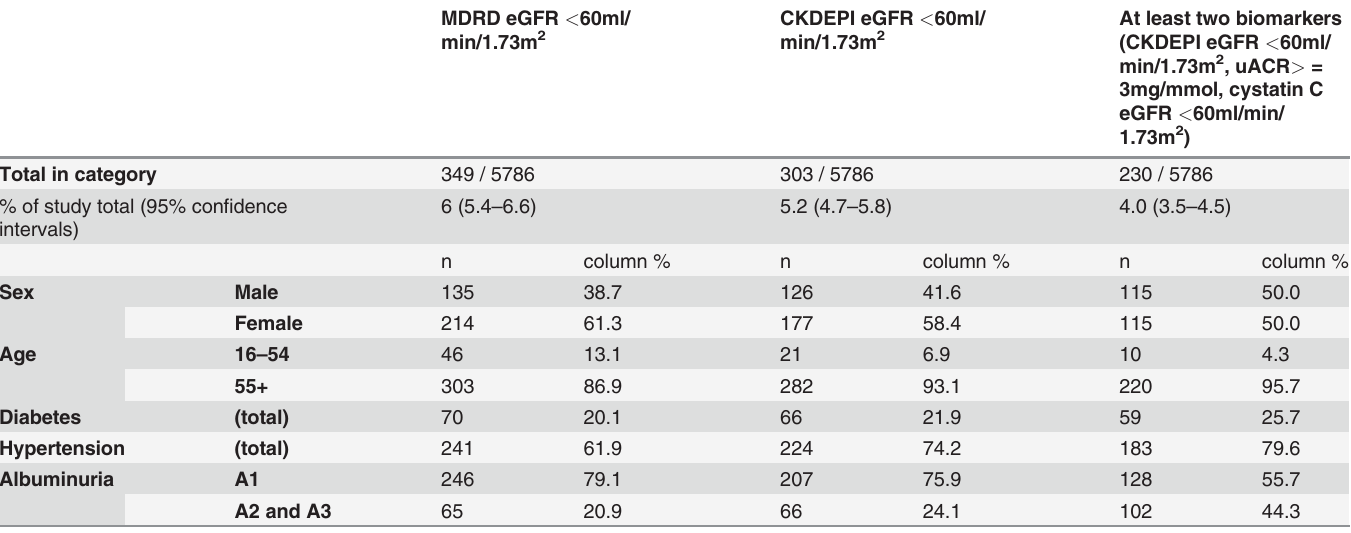
Table 2. Sociodemographic and clinical characteristics of people with CKD 3 – 5 de fi ned by eGFR (from MDRD and CKDEPI equations) and after targeted addition of cystatin